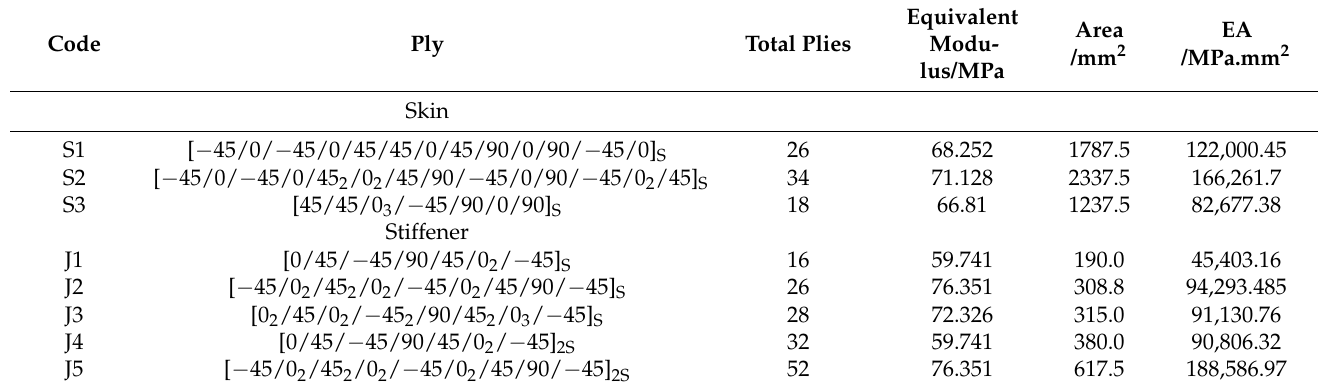
Table 8. Ply information of skins and